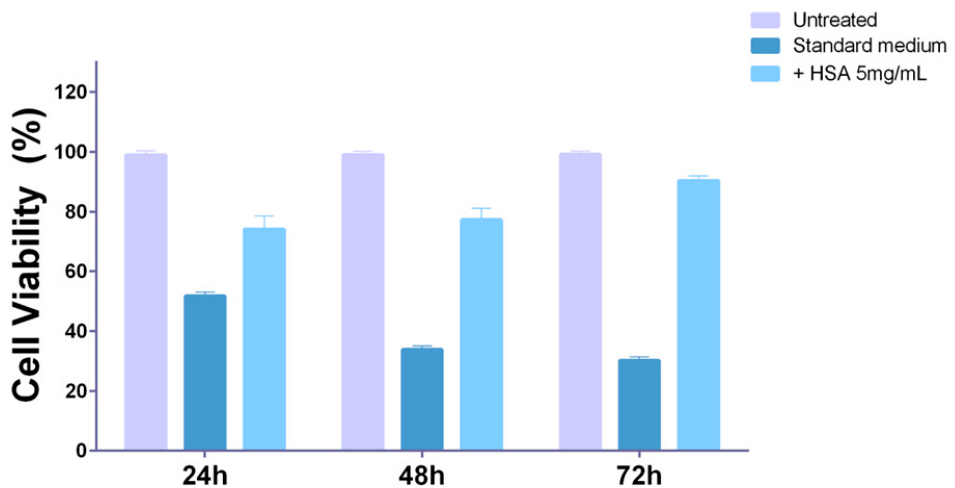
Figure 6. Cell viability of MDA-MB-231 cells in the presence of HSA. An MTT assay was conducted on MDA-MB-231 cells to evaluate the effects of the higher concentration of NG (5 × 10 − 3 wt%) on cell viability in standard medium (dark blue bars) and in the presence of 5 mg/mL of additional HSA (light blue bars), with respect to untreated MDA-MB-231 (light violet bars). Cell viability, expressed as a percentage of viable cells, is reported as a function of the incubation time with Fmoc-FF nanogel.